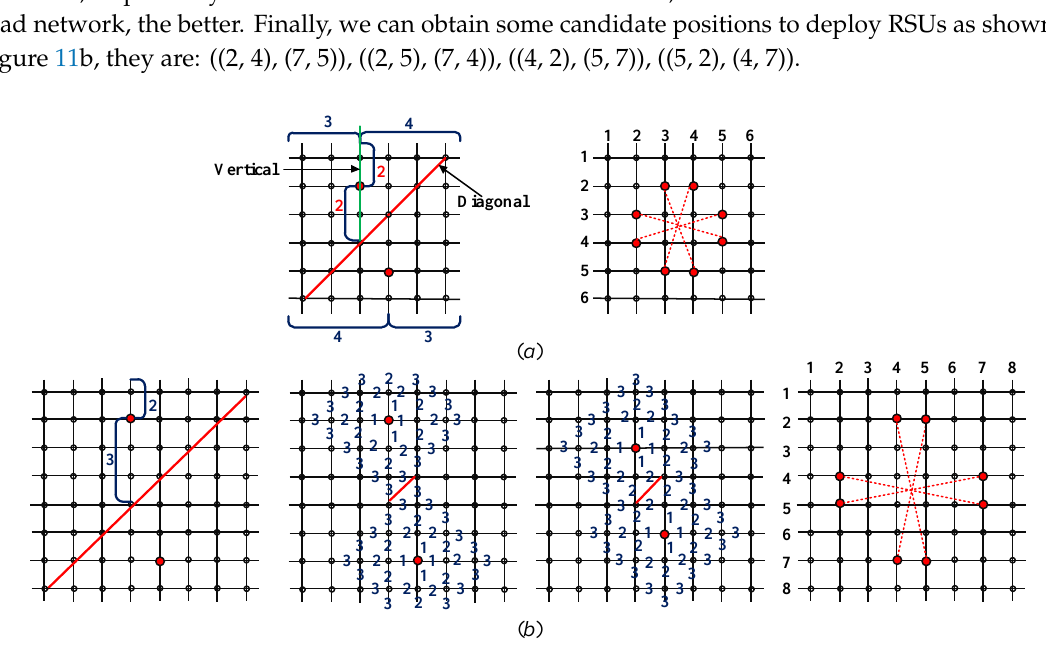
Figure 12. Center rule (K = 3).